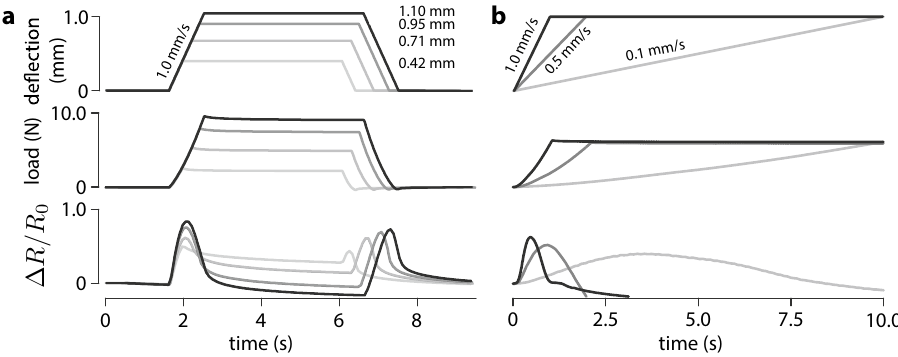
Figure 2. Sensor response. ( a ) Dependence of the response on deflection magnitude. Lines with grey levels indicate different deflections. ( b ) Dependence of the response on deflection rate. Lines with grey levels indicate different rates.